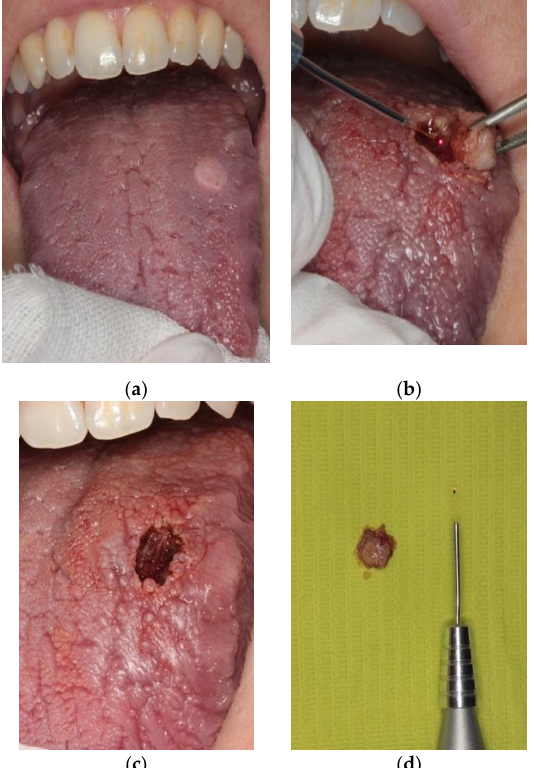
Figure 1. ( a ) Clinical appearance of granular cell tumor of the left dorsum of the tongue. ( b ) Surgical excision of the lesion with 445 nm diode laser. ( c ) Immediate post-surgical appearance. Complete hemostasis. ( d ) Surgical specimen.